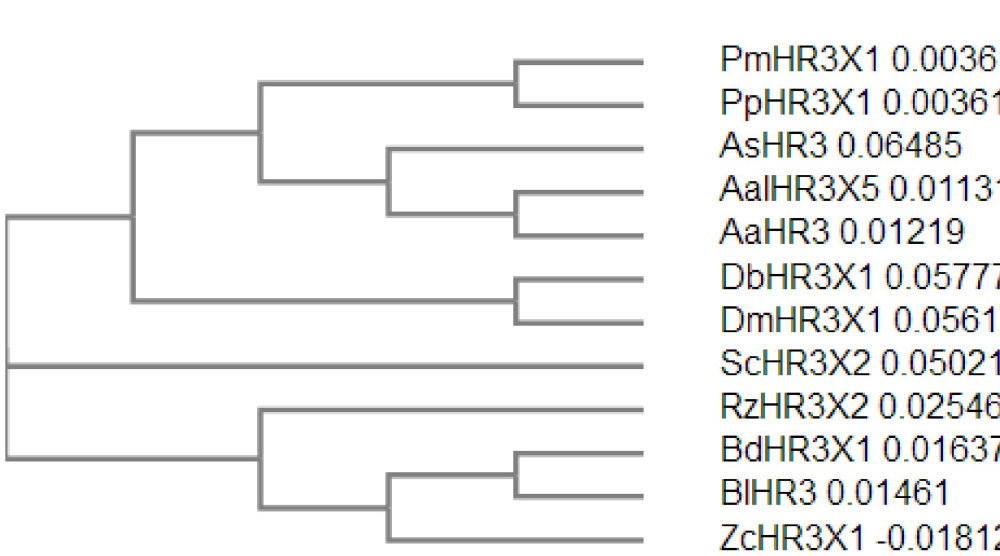
Fig 2. Phylogenetic tree of Aedes aegypti HR3 with its homologs. Protein sequences are from Papilio machaon (PmHR3X1, XP_014364014), Papilio polytes (PpHR3X1, XP_013136657), Drosophila biarmipes (DbHR3X1, XP_016947144), Drosophila miranda (DmHR3X1, XP_017149048), Stomoxys calcitrans (ScHR3X2, XP_013103855), Rhagoletis zephyria (RZHR3X2, XP_017466500), Bactrocera dorsalis (BdHR3X1, XP_019847140), Zeugodacus cucurbitae (ZcHR3X1, XP_011182274), Bactrocera latifrons (BlHR3, XP_018799932), Anopheles sinensis (AsHR3, KFB44899), Aedes albopictus (AalHR3X5, XP_019549827), and Aedes aegypti (AaHR3, AF230281, AAEL009588-PA). Neighbor-joining phylogenetic tree was constructed based on protein alignments of HR3 proteins using ClustalX2.